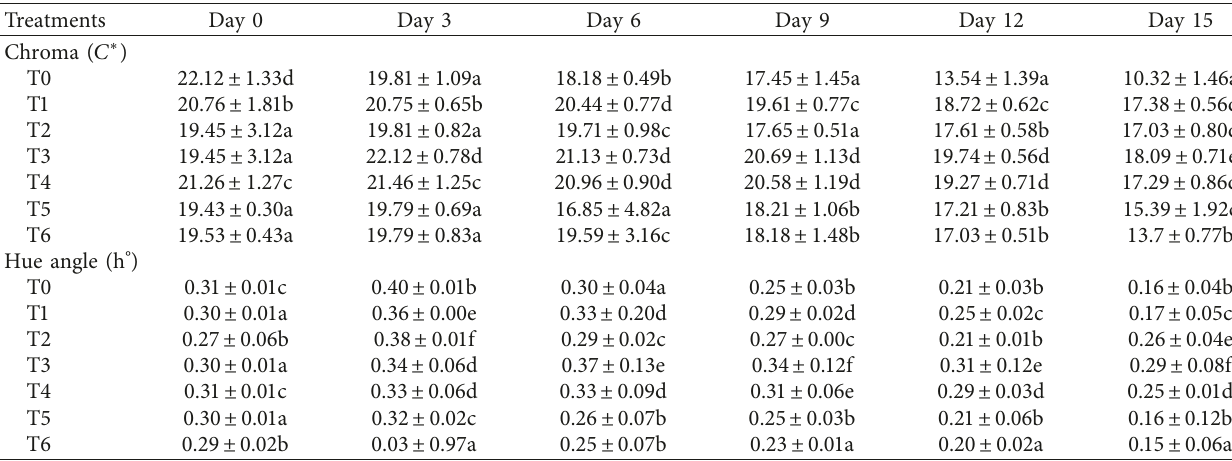
Values are expressed in mean ± SD ( n � 3) ( P ≤ 0 . 05). a, b, c, d, and e indicate significant differences in treatments compared to control with respect to an interval of 3 days (storage days 0, 3, 6, 9, 12, and 15 days, resp.). T0 � control, T1 � chitosan 1%+cinnamon oil 0.25%, T2 � chitosan 1%+cinnamon oil